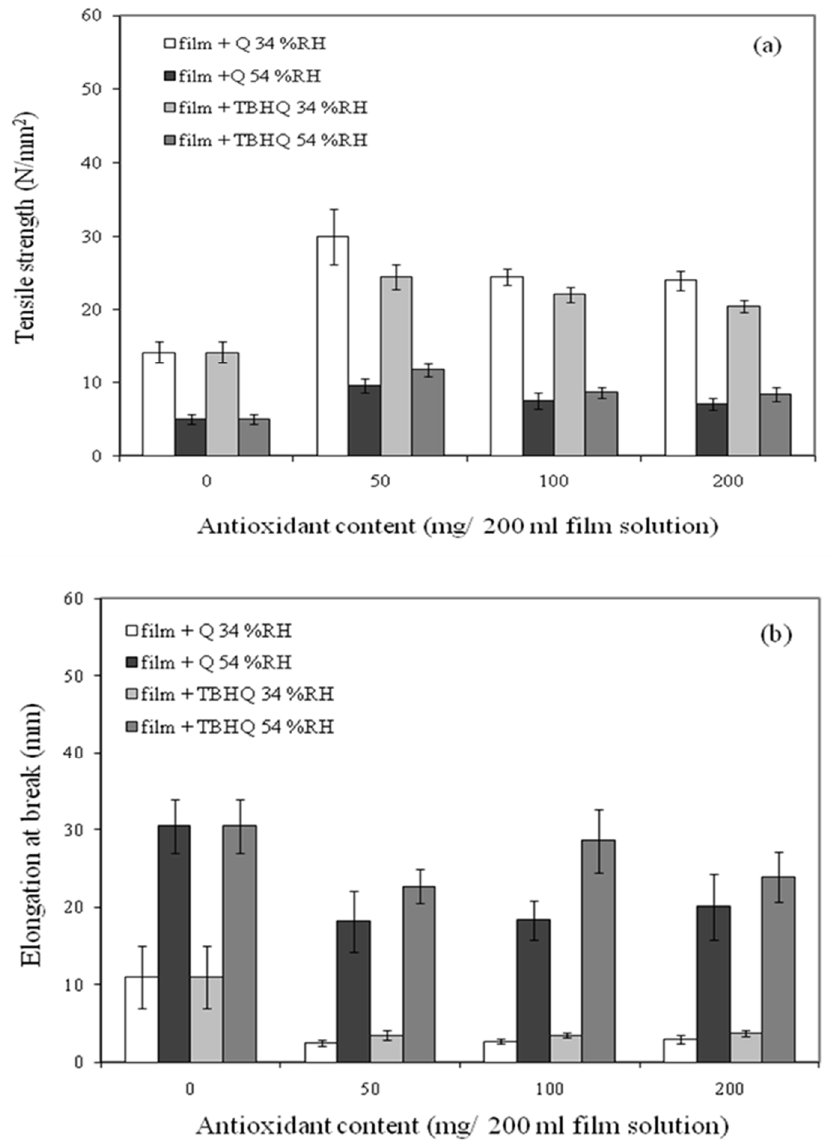
Figure 1. Effect of quercetin and tertiary butylhydroquinone (TBHQ) contents on ( a ) tensile strength and ( b ) elongation at break of cassava starch– carboxymethyl cellulose (CMC films at 34% and 54% RH).